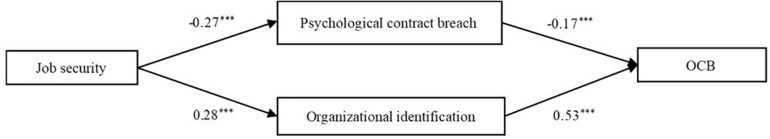
Final model estimators for total workers. ***p < 0.001.